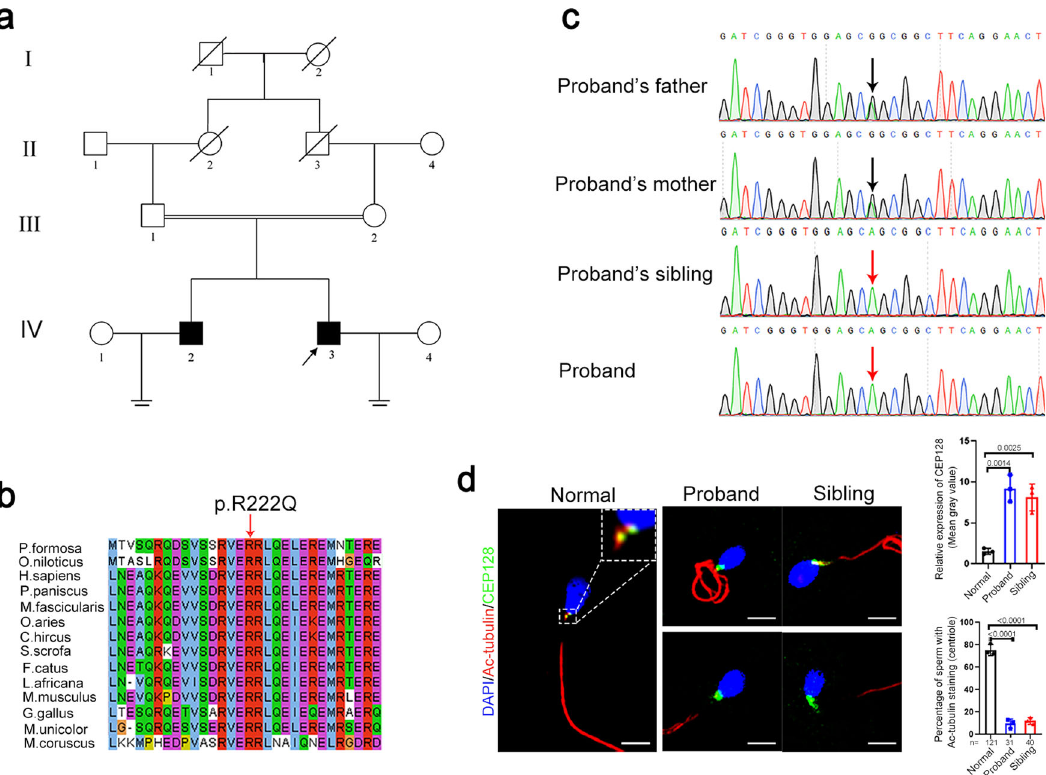
Fig. 2 Identi fi cation of a homozygous variant in CEP128 in two infertile siblings with cryptozoospermia from a consanguineous family. a Pedigree of the consanguineous family with two infertile males (IV-2 and IV-3), with the arrow pointing to the proband. b Site of the CEP128 missense variant is evolutionally conserved among various species. c The affected males carry the homozygous missense variant in CEP128 ; the homozygotes are indicated by red arrows and the heterozygotes by black arrows. d CEP128 was localized to both PC and DC in the control spermatozoa. Dotted box denotes the colocalization of CEP128 with PC and DC. Increased abundances of CEP128 protein were observed in the sperm neck of the two siblings harboring a homozygous CEP128 variant. Quanti fi cation of anti-CEP128 staining density in spermatozoa from control and patients. Quanti fi cation of the number of sperm with anti-Tubulin staining in the control and patients. Three independent experiments were performed. n the number of spermatozoa analyzed, PC proximal centriole, DC distal centriole. (Two-sided Student ’ s t test; error bars, mean ± SEM; green, CEP128; red, Ac-Tubulin; blue, DAPI; scale bars, 5 µ m). The p values are indicated in the graphs. Source data are provided as a Source Data fi (WT)- CEP128 and Flag- CEP128 R222Q plasmids and transfected them into 293T cells. The western blot results showed con-